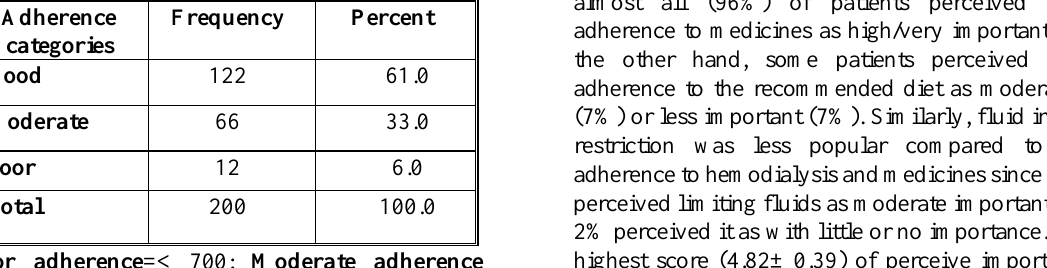
Table 3. The adherence categories according to the ESRD-adherence questionnaire